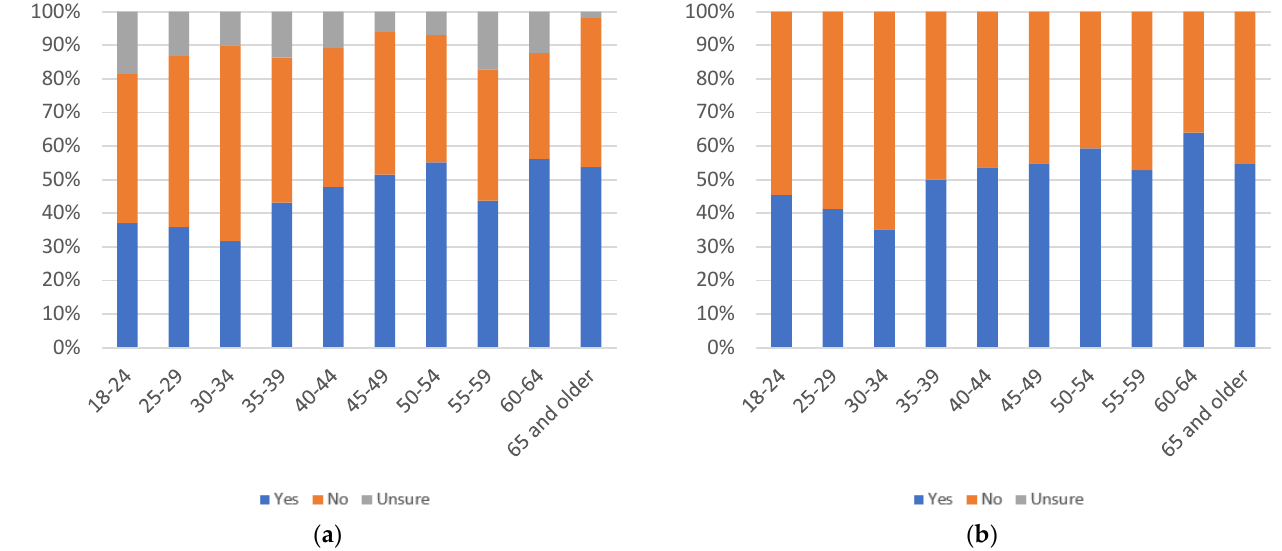
Figure 40. Label annoyingness, by age group: ( a ) with uncertain respondents (left) and ( b ) without uncertain respondents (right).